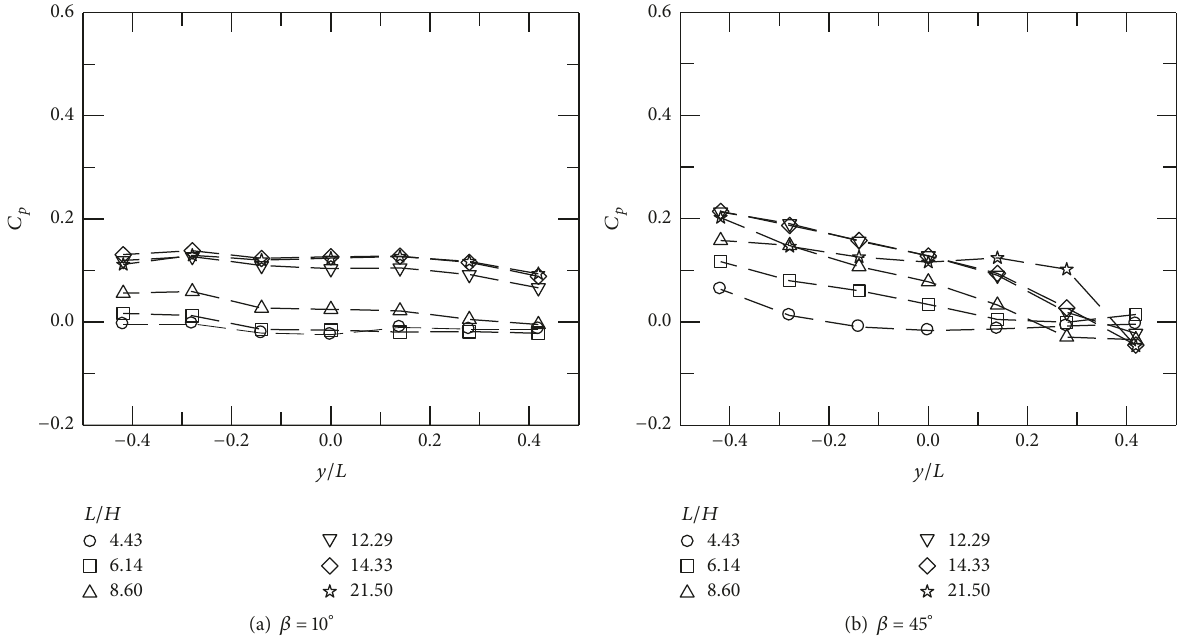
Figure 9: Span-wise mean surface pressure distributions for M = 0.83: (a) 𝛽 = 10 ∘ and (b) 𝛽 = 45 ∘ .